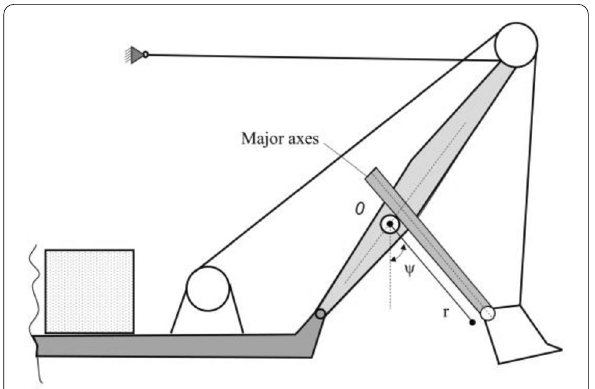
Figure 2 Polar coordinate system built in the dynamic